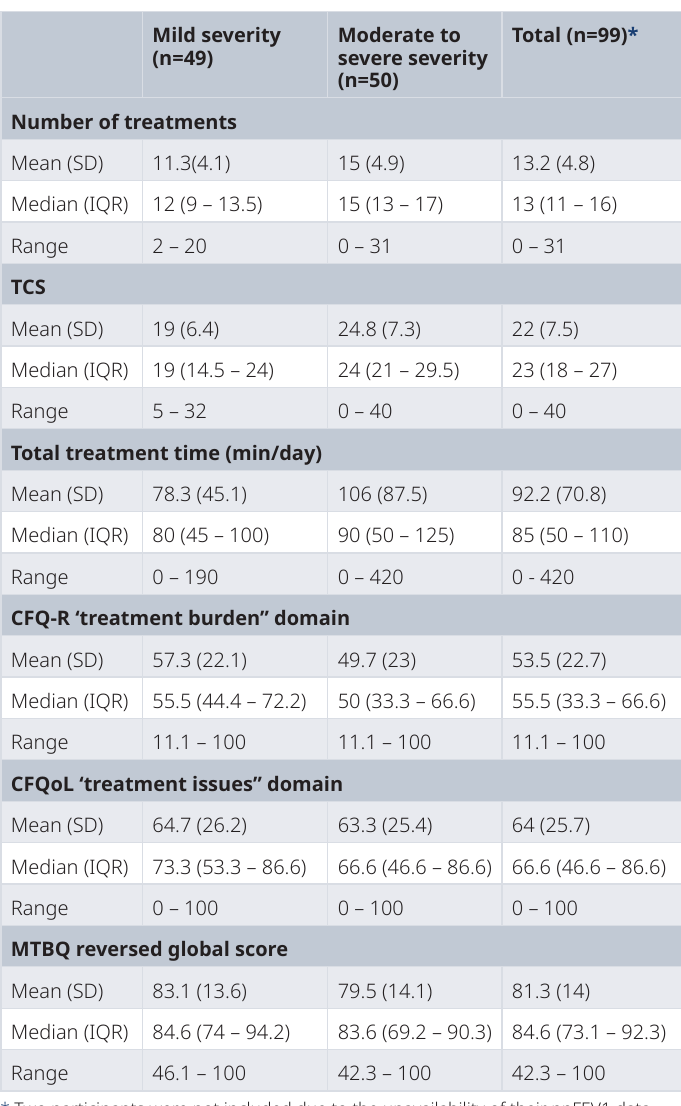
Table 5. Treatment descriptors and treatment burden instruments descriptive statistics based on disease severity groups.